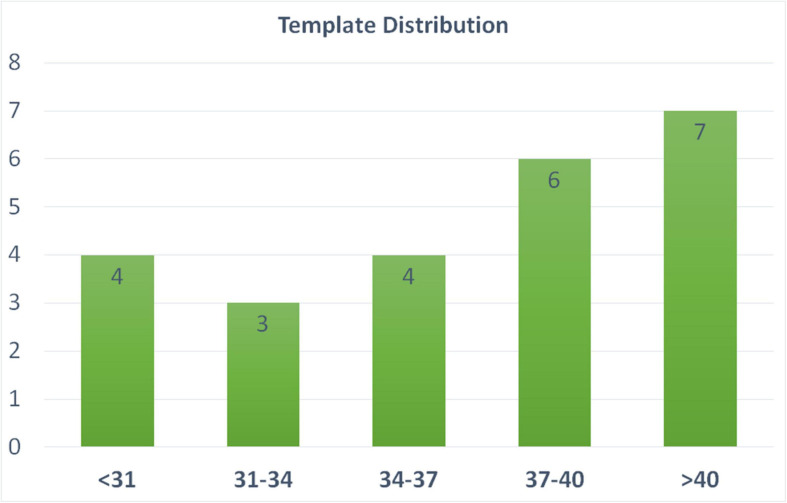
Age distribution of the templates selected in our pipeline. These templates are utilized in both brain extraction and tissue segmentation. X-axis label represent the PMA weeks.